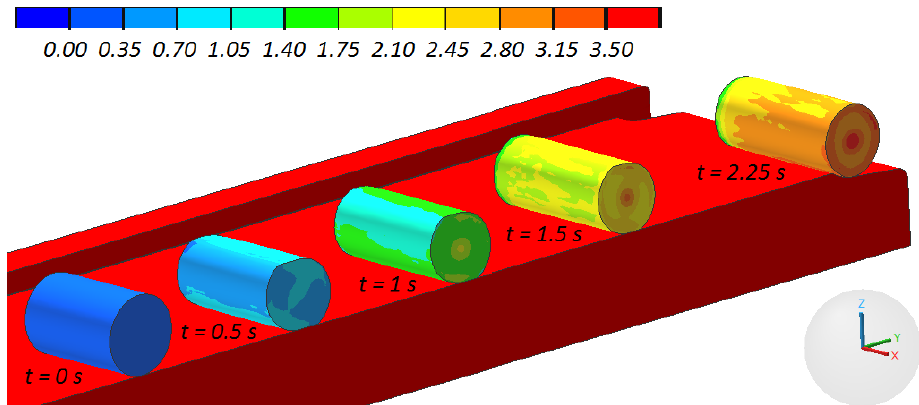
Figure 6. Progression of the sample shape, with the distribution of the effective strain, in the process of rotational compression of a sample with the initial length equal 90 mm (the upper tool was hidden for better visibility).